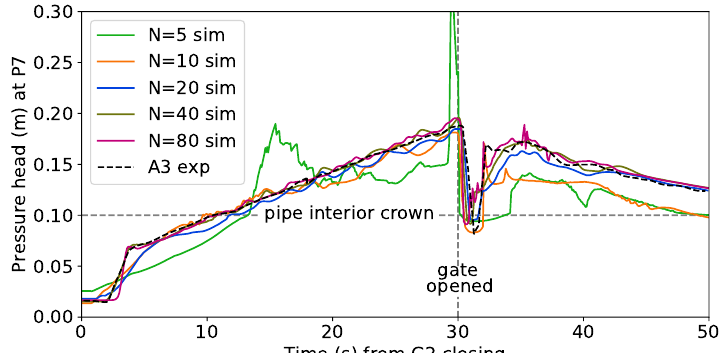
Figure 7. Pressure head at P7 sensor 0.6 m upstream of G2 for grid refinement simulations of Case A3. See Table 4 for details.